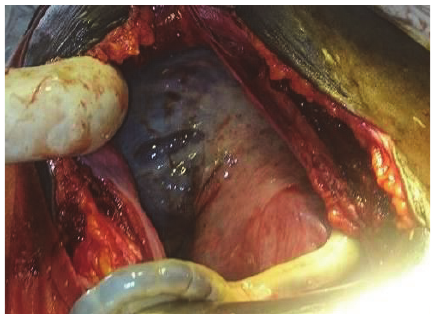
Figure 1: View of the placenta and uterus after extraction of the foetus.